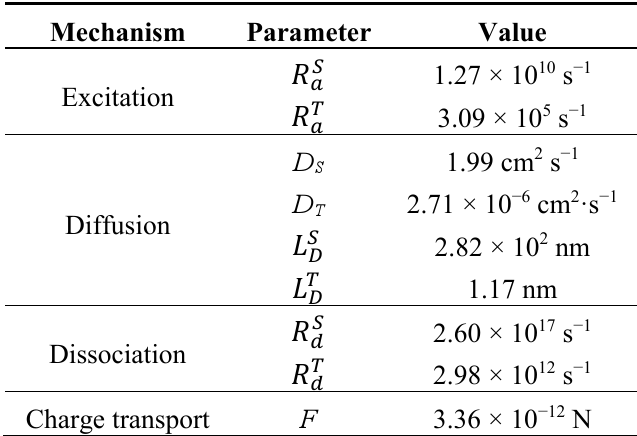
Table 1. Rates of excitation, diffusion and dissociation in PET/PEDOT:PSS/TFB/ P3HT:SiNW/Ca hybrid solar